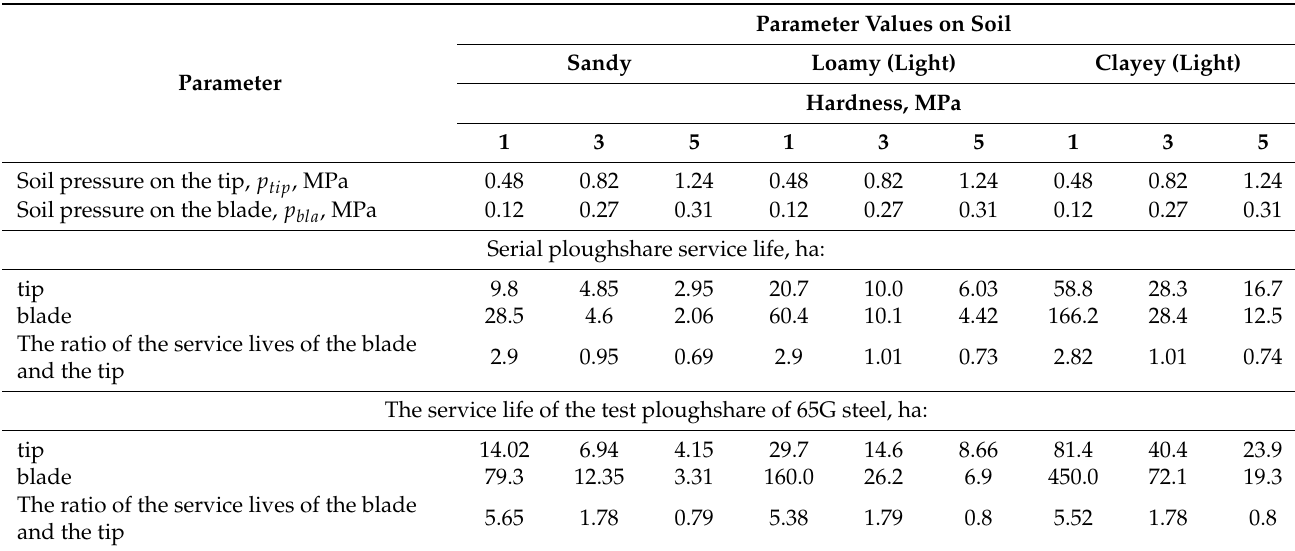
Table 2. The calculation